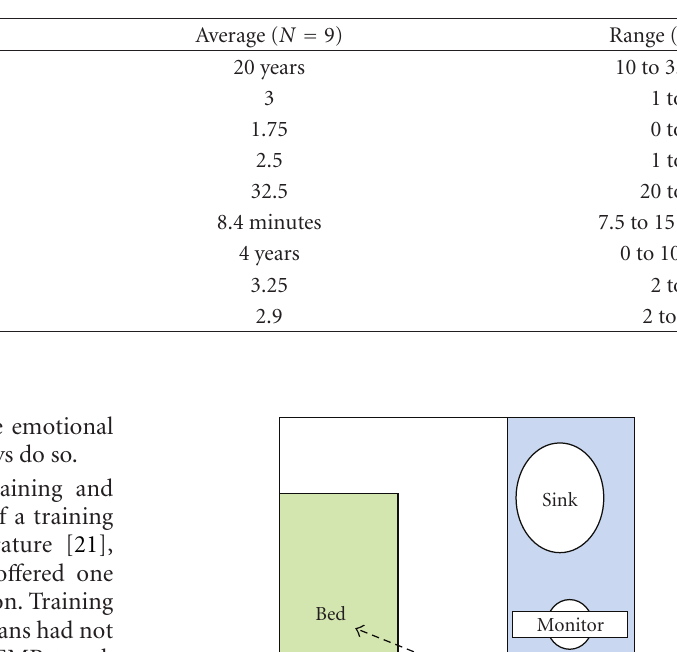
Table 2: Closed-ended interview results: statistics describing the number and experience of physicians, patient throughput, years of experience using an EMR, computer skills, and clinic size.